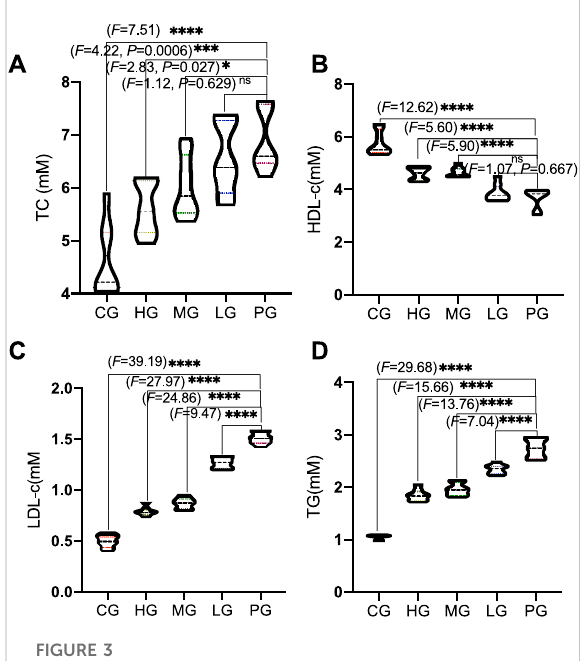
FIGURE 4 Radical scavenging activities of ApoAI MP among different groups. (A) , DHHP. (B) , ABTS. (C) , superoxide anion. (D) , P > 0.05, . ns